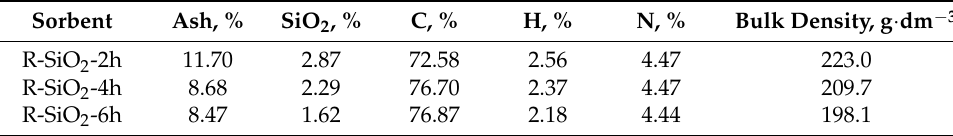
Table 1. Chemical composition of silica-doped biochars.